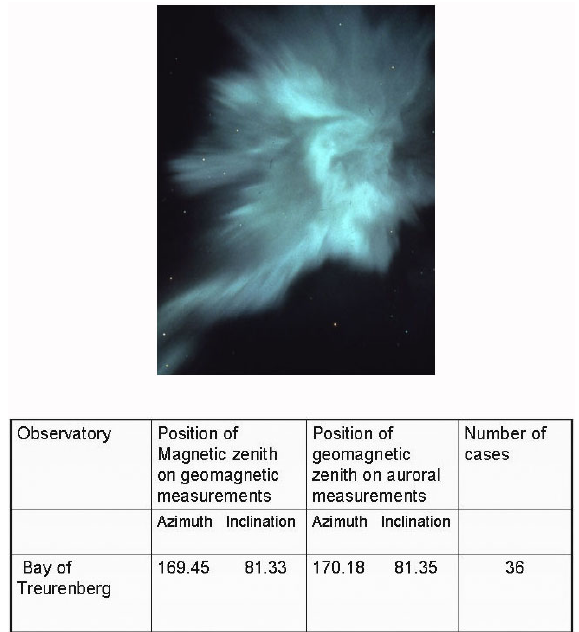
Fig. 13. Photo of a corona, together with the magnetic zenith posi- tions obtained by Westman from simultaneous optical and magnetic measurements. Photo T. L¨ovgren.